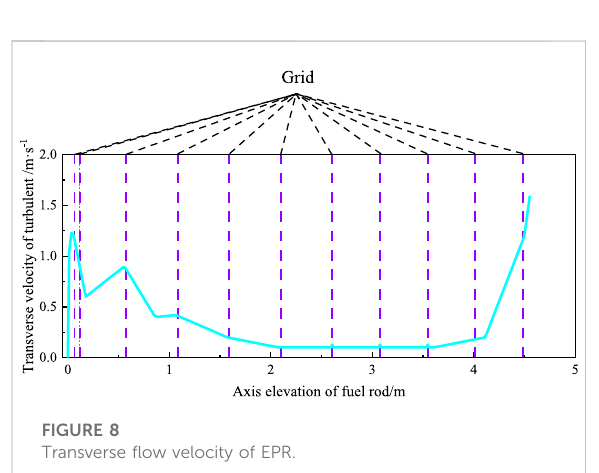
FIGURE 8 Transverse fl ow velocity of EPR.